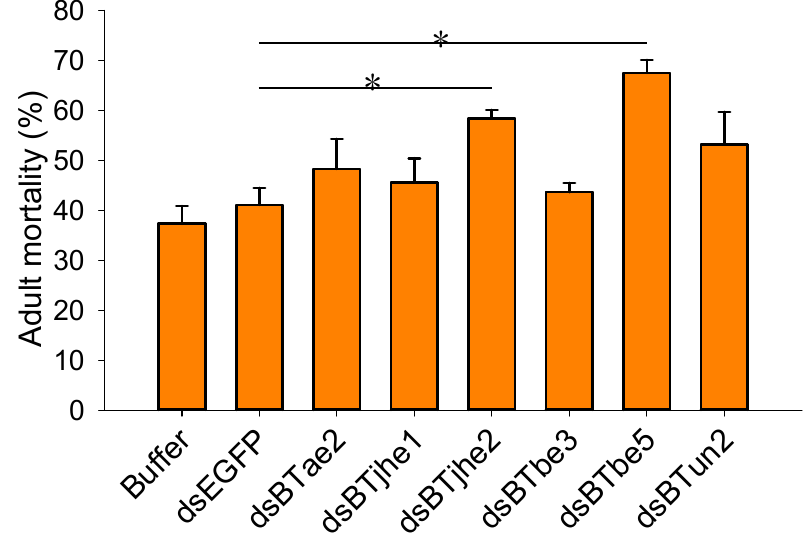
Figure 6. E ff ect of silencing COE genes on B. tabaci susceptibility to imidacloprid. Susceptibility to imidacloprid in B. tabaci adults fed bu ff er (without dsRNA), dsEGFP, or dsRNA targeting COE genes was tested using feeding chambers. Asterisks indicate significant di ff erences between treatments (dsRNA) and the control (dsEGFP) ( p < 0.05; Holm–Sidak test; n =